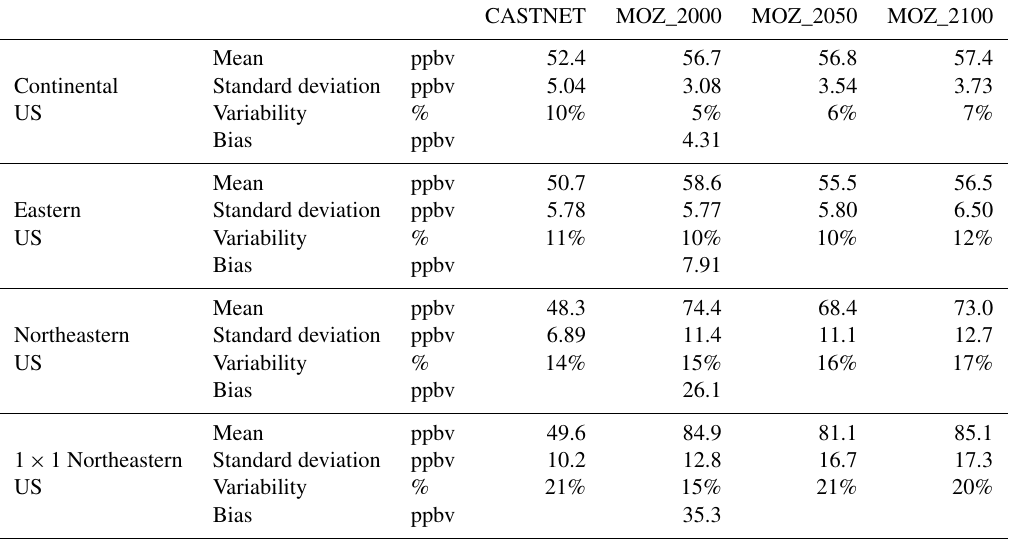
Table 1. Statistical Summary of the CASTNET observations and the three CAM-chem simulations for different spatial averaging regions within the US. Variability is defined as the standard deviation divided by the mean value (in percent). Biases are only included for the present-day CAM-chem simulation compared to the CASTNET data. Similar tables for the other regions in this study are included in the